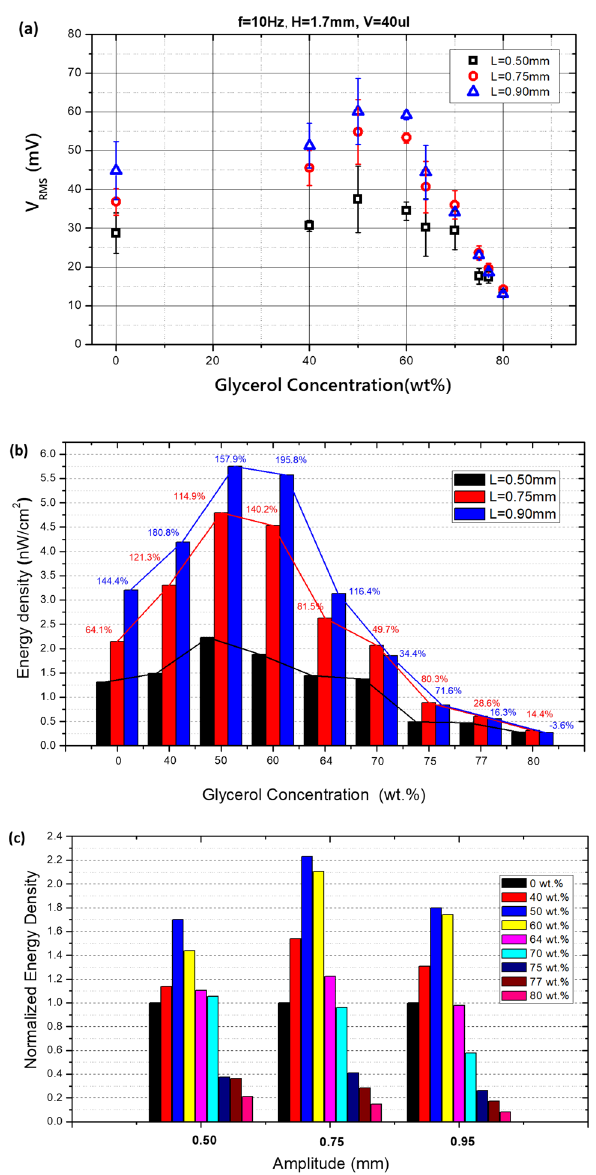
Figure 9. Experimental results of energy output: ( a ) V RMS , ( b ) energy density, and ( c ) normalized energy density based on pure